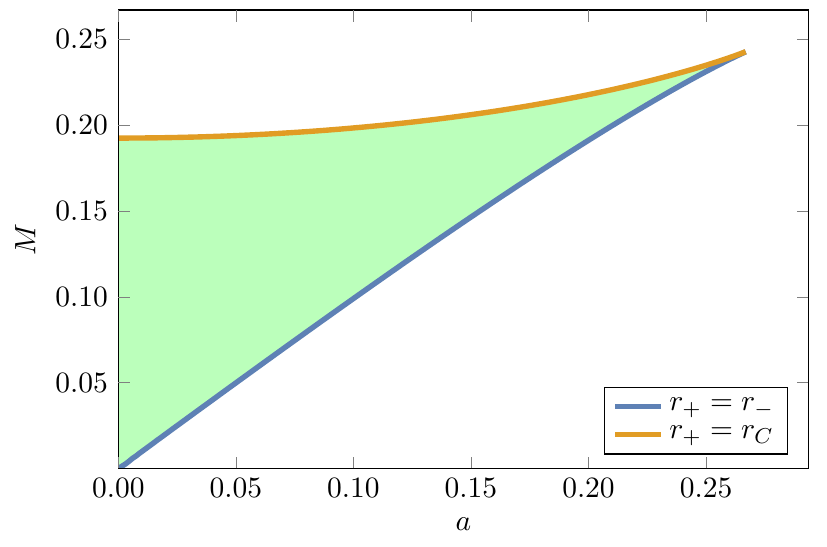
Figure 2 . The green region correspond to values of ( M; a ) (with L = 1) representing black hole solutions. The blue line corresponds to r + = r (cid:0) and the orange line to r + = r C .